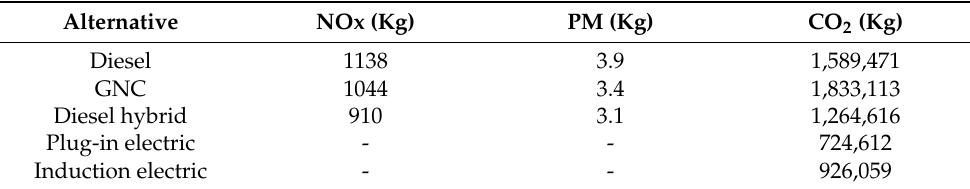
Table 12. Pollutant emissions in the ELECTRE TRI model by